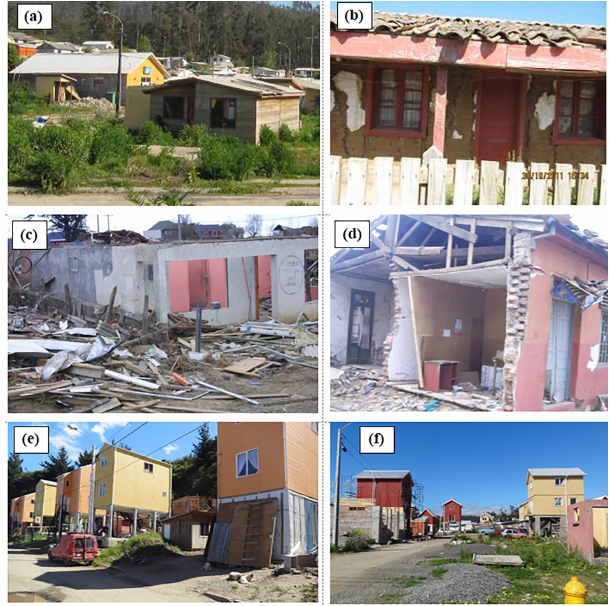
Figure 11. Pre-disaster (a, b, c, d) and post-disaster (e, f) housing in